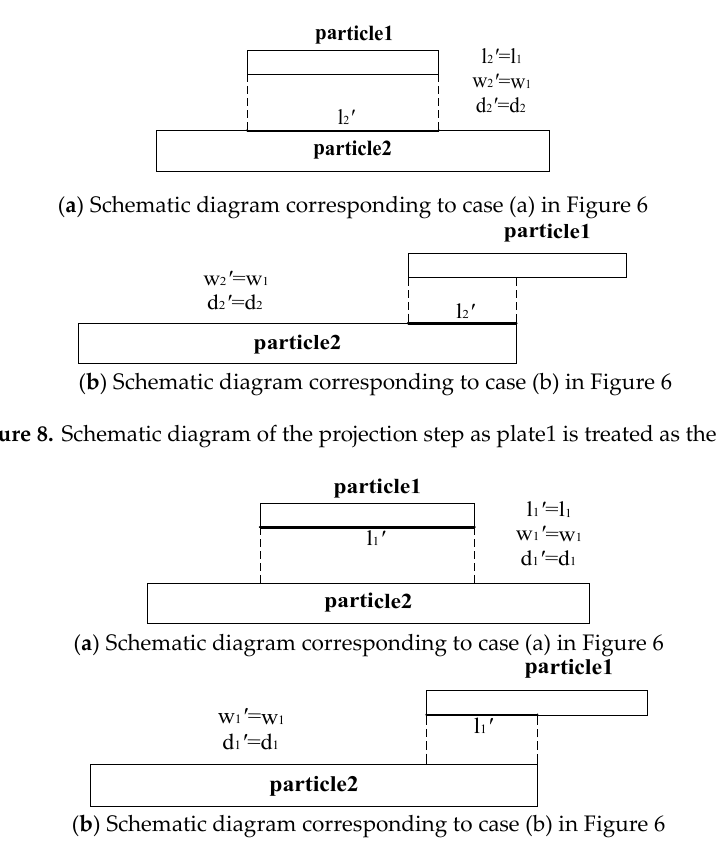
Figure 7. Comparison of the calculated forces with different choices of the ideal wall.